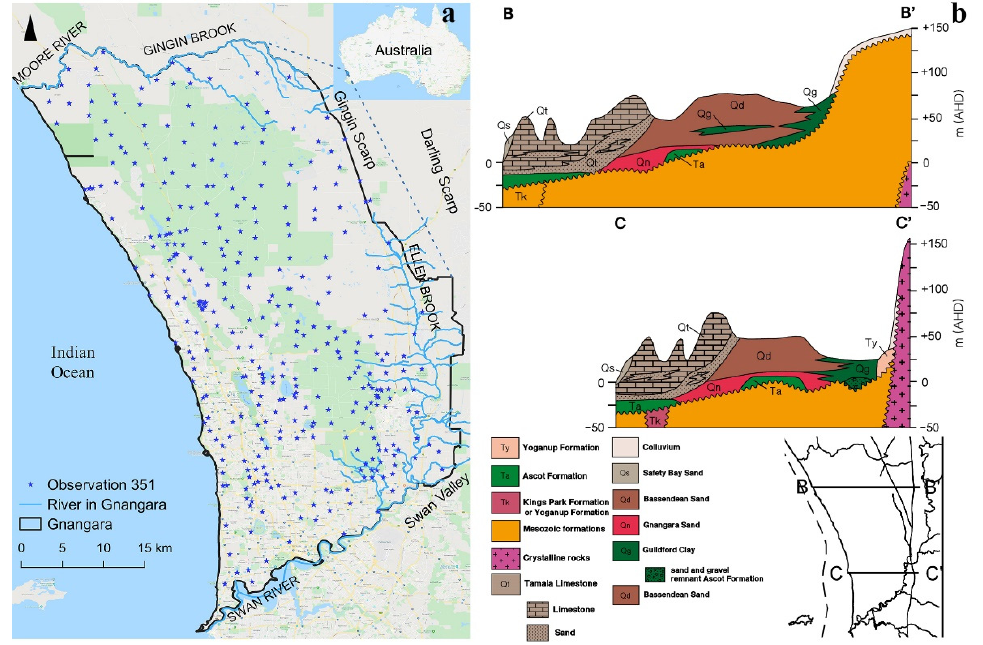
Figure 1. ( a ) Location of the Gnangara region and the groundwater level observations in the study area. ( b ) Geological cross section of the study area [46].